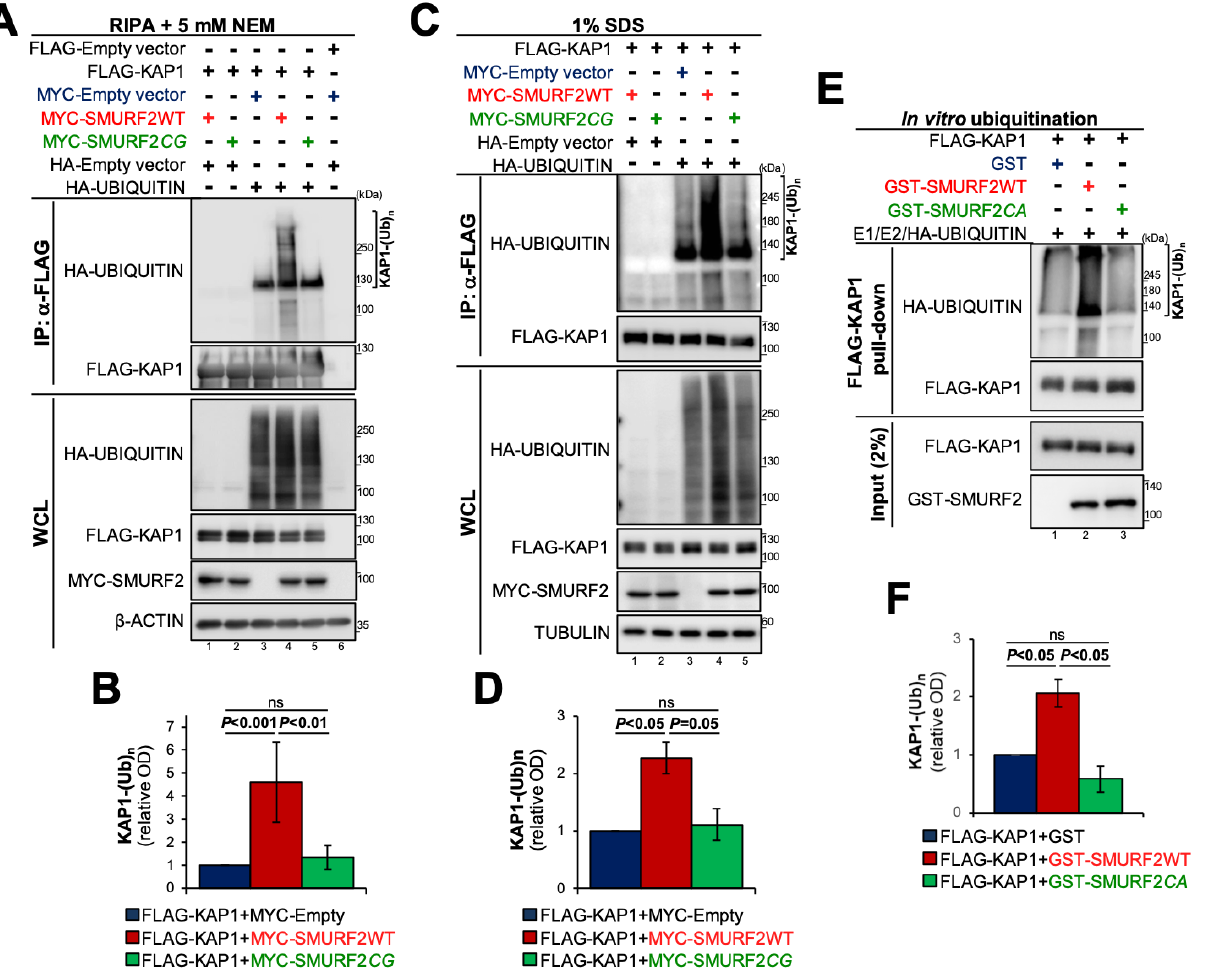
Figure 2. KAP1 is a direct ubiquitination substrate of SMURF2 . ( A ) In cellulo ubiquitination assay showing SMURF2 ‐ mediated ubiquitination of KAP1 and its dependency on E3 ligase activity of SMURF2. HEK ‐ 293T cells. Cells were lysed in RIPA buffer supplemented with the deubiquitinase inhibitor NEM. ( B ) Quantification of the data shown in ( A ) obtained in six different experiments. Data are mean ± SD. ns—non ‐ significant. ( C ) In cellulo ubiquitination assay following cell lysis in 1% SDS. HEK ‐ 293T cells. ( D ) Quantification of the data presented in ( C ) obtained from two inde ‐ pendent experiments. Data are mean ± SD. ( E ) In vitro ubiquitination assay showing ubiquitination of purified FLAG ‐ KAP1 by GST ‐ SMURF2. Catalytically ‐ inactive GST ‐ SMURF2 CA and GST were used as additional controls. ( F ) Quantification of the results obtained in two separate in vitro ubiq ‐ uitination assays. Data are mean ± SD. The uncropped Western blot images can be found in Figure S6.